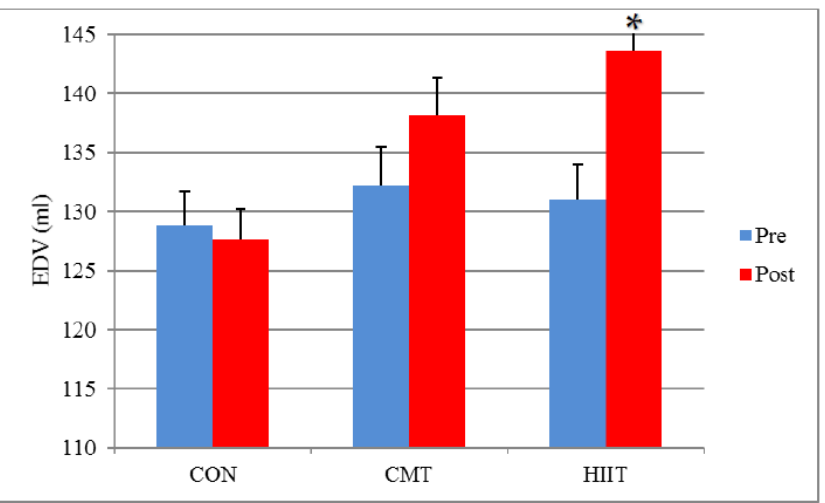
Figure 2. EDV Changes before and after 12 Weeks of CMT and HIIT; * Indicates a significant increase compared with the CMT and control groups ( p < 0.05). EDV: End-Diastolic Volume (mL). CON: Control. CMT: Continuous Moderate Training. HIIT: High-Intensity Interval Training.